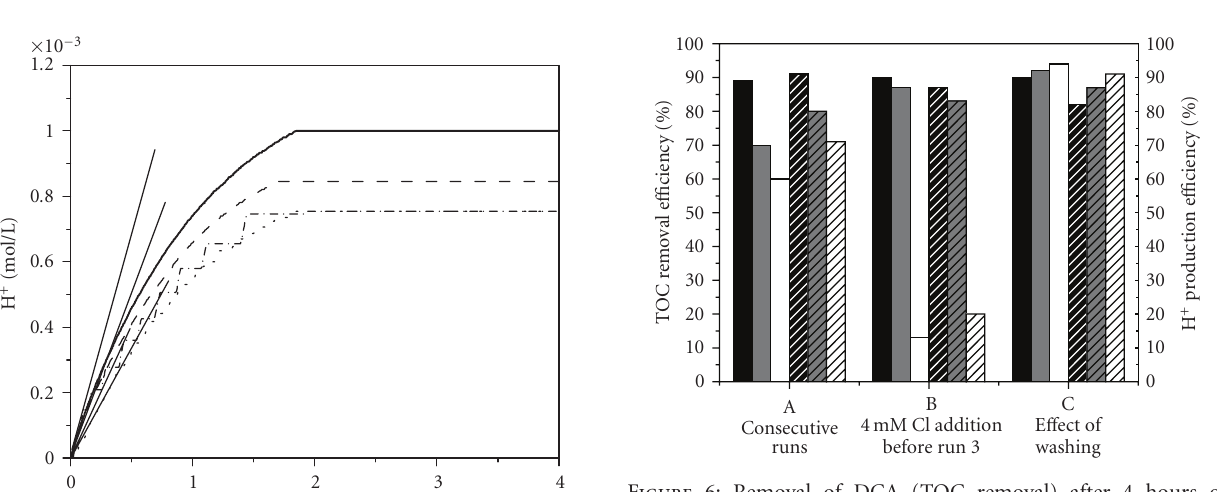
Figure 6: Removal of DCA (TOC removal) after 4 hours of illumination using the photocatalyst 0.35 Ag-TiO 2 at pH 3 in 3 consecutive runs (1st run (cid:2) , 2nd run , and 3rd run (cid:3) ), the H + production e ffi ciency after 4 hours of illumination is also shown (1st run , 2nd run , and 3rd run ) in set A, with chloride ion addition in set B before the third run and with intermittent washing between runs (set C). The photocatalyst loading was 0.5g/L and the light intensity I ≈ 3 . 39 × 10 − 2 Einstein L − 1 h − 1 .